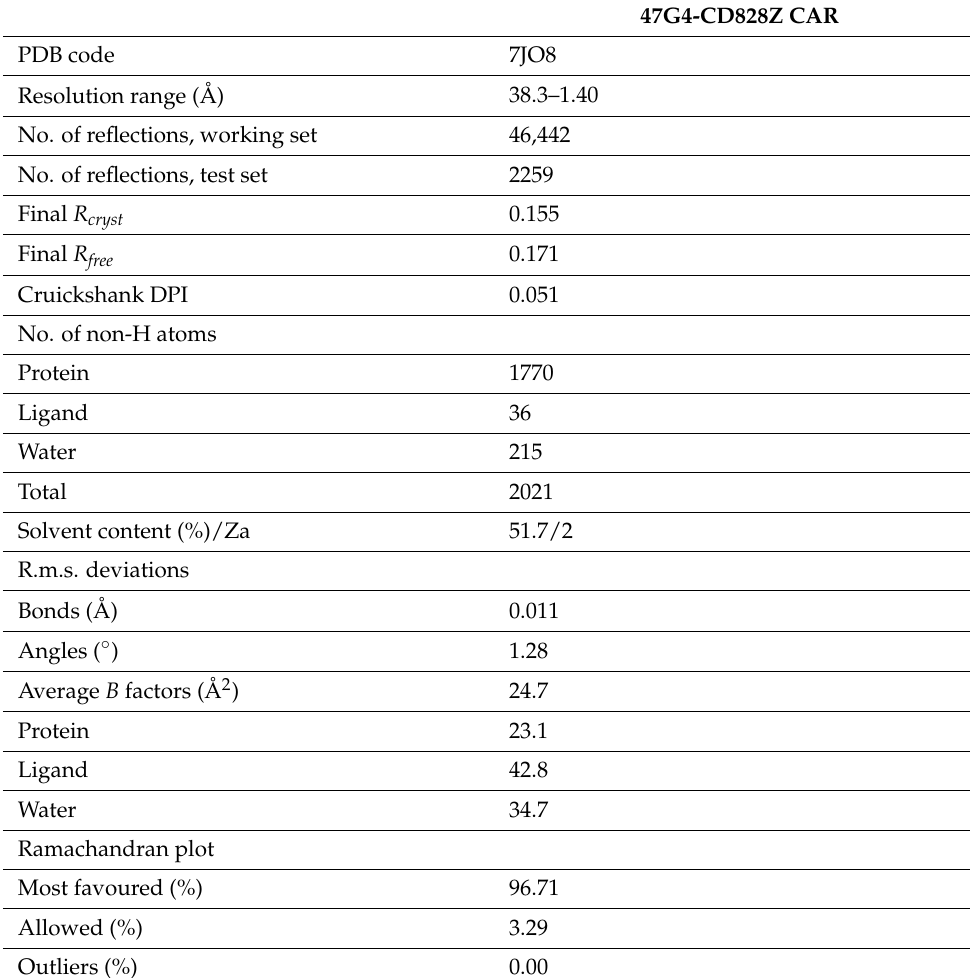
Table 3. Structure solution and